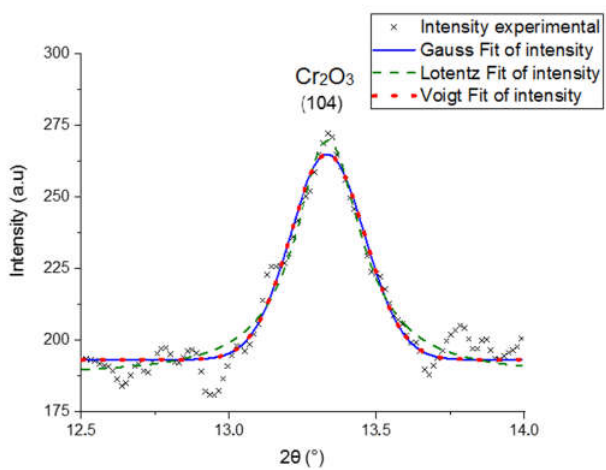
Figure 8. Different peak profiles simulation.